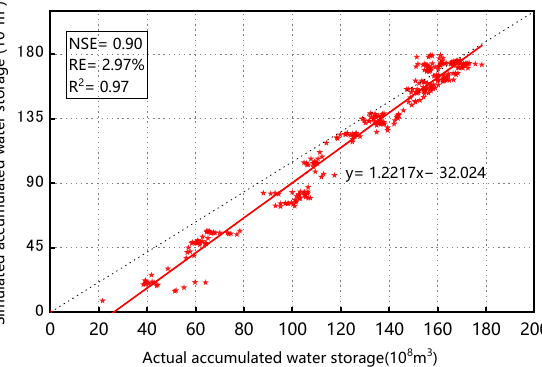
Figure 4. Comparison between actual and simulated accumulated lake water storage during the simulation period.